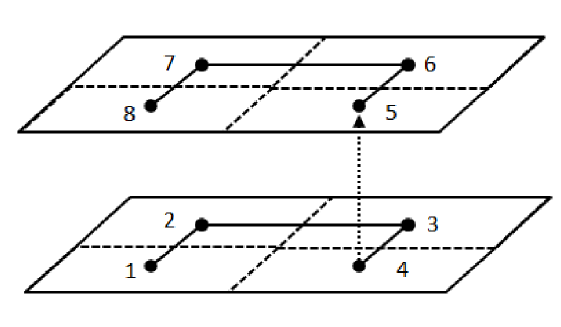
Figure 9: Possible approach of 3D Hilbert order where n = 2 (Haverkort and Walderveen, 2008) Figure 10: 3D Hilbert